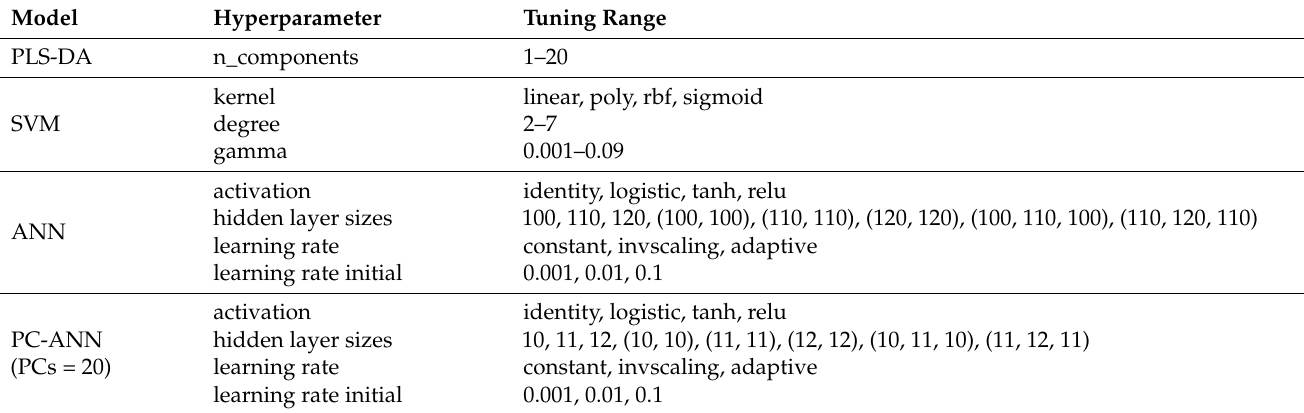
Table 2. Predefined parameters for performing GridSearchCV command on 5-fold cross